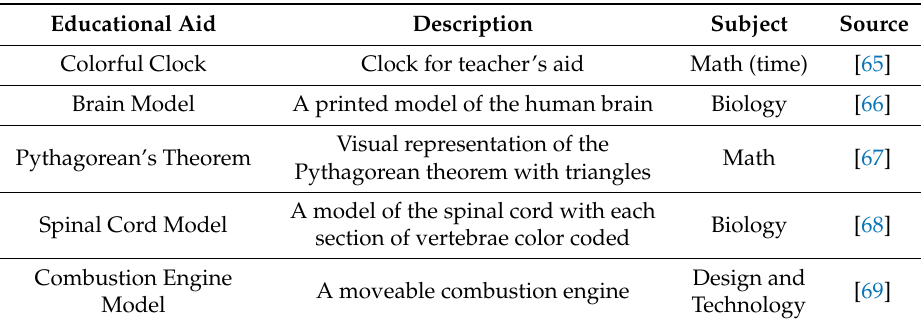
Table 1. Educational aids 3-D printed with a description of what it does and the subject it would be used for to enhance